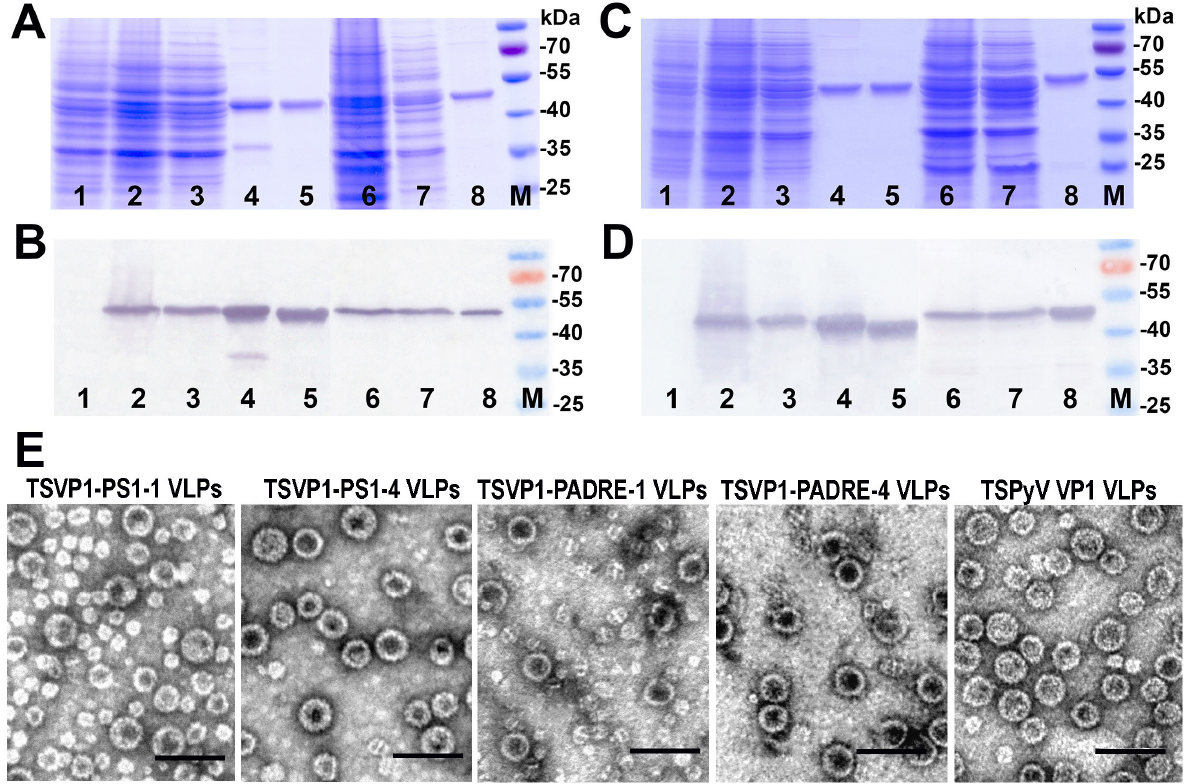
Figure 4. Analysis of the production of chimeric proteins TSVP1-PS1 ( A , B ) and TSVP1-PADRE ( C , D ) in yeast by SDS-PAGE ( A , C ) and Western blot with TSPyV VP1-specific MAb 17A5 ( B , D ). In all gels, the lysate of yeast cells transformed with an empty pFX7 plasmid (lane 1, negative control), the purified unmodified TSPyV VP1 protein (lane 5, positive control) and the pre-stained protein molecular weight marker (Thermo Fisher Scientific Baltics, lane M) were loaded. Chimeric TSVP1-PS1-1 (( A , B ); lanes 2–4), TSVP1-PS1-4 (( A , B ); lanes 6–8), TSVP1-PADRE-1 (( C , D ); lines 2–4) and TSVP1-PADRE-4 (( C , D ); lines 2–4) proteins were examined in the whole yeast cell lysates (lanes 2 and 6), lysate supernatants (lanes 3 and 7) and after purification (lanes 4 and 8). ( E ): Electron micrographs of TSVP1-PS1, TSVP1-PADRE and the unmodified TSPyV VP1 VLPs.